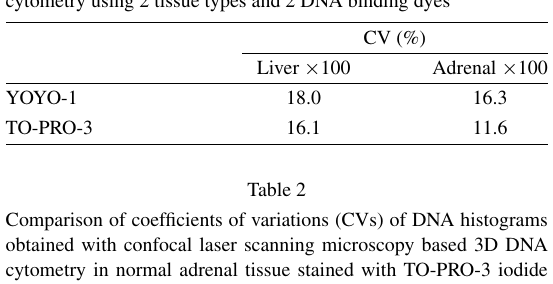
Comparison of coefficients of variations (CVs) of DNA histograms obtained with confocal laser scanning microscopy based 3D DNA cytometry using 2 tissue types and 2 DNA binding dyes